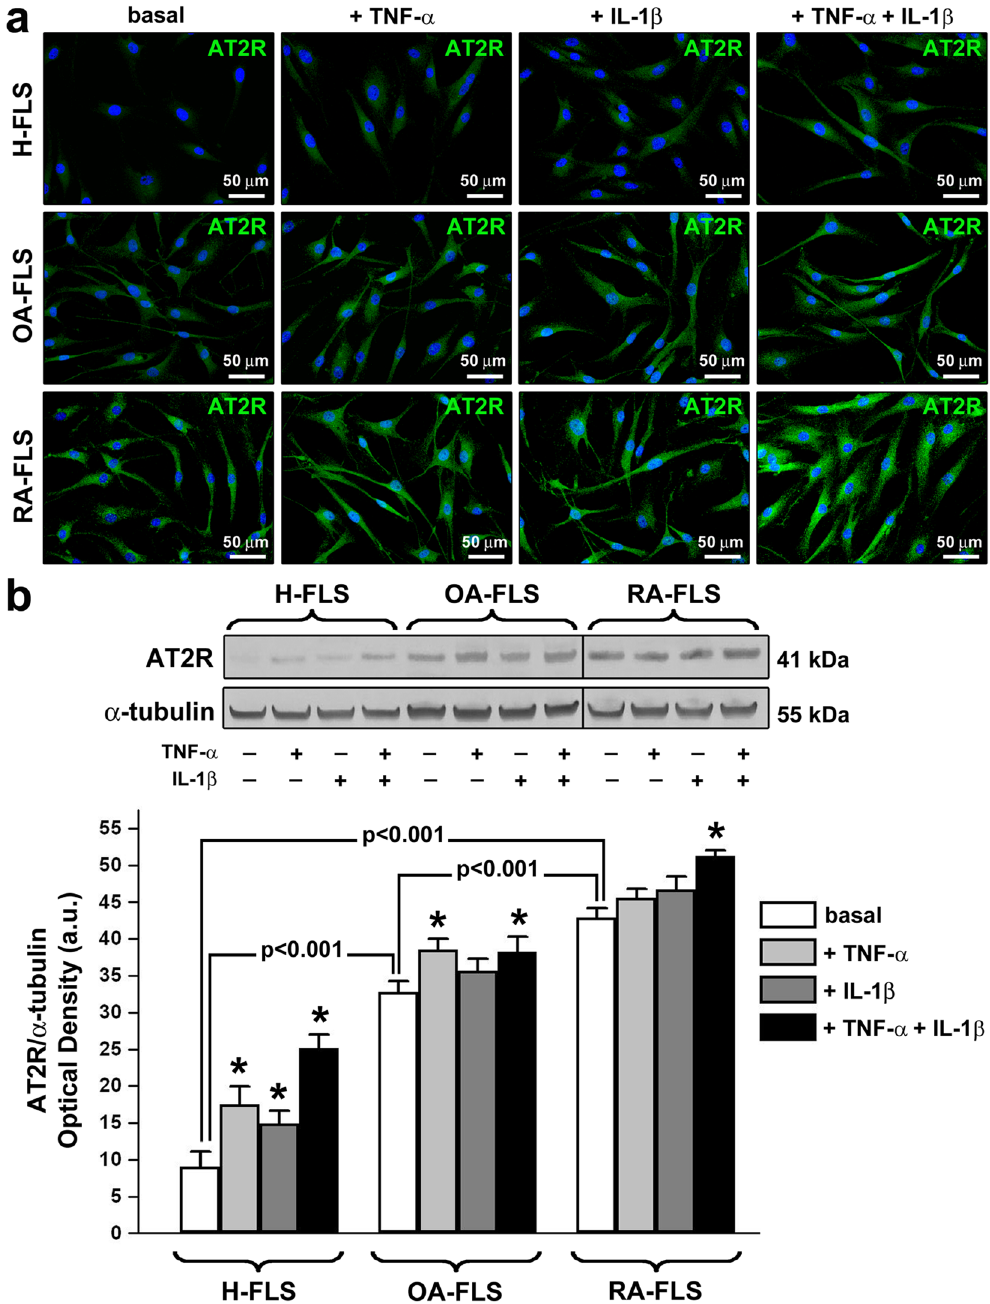
Figure 3. Expression of angiotensin II type 2 receptor (AT2R) in fibroblast-like synoviocytes (FLS) from healthy, osteoarthritis (OA) and rheumatoid arthritis (RA) synovium at baseline and after treatment with tumor necrosis factor (TNF)- α and interleukin (IL)-1 β , alone or in combination. ( a ) Representative microphotographs of FLS isolated from healthy (H-FLS), OA (OA-FLS) and RA (RA-FLS) synovium subjected to immunofluorescence staining for AT2R (green) and nuclear counterstaining with 4 ′ ,6-diamidino-2- phenylindole (DAPI; blue). Scale bars are indicated in each panel. ( b ) Western blotting of total protein extracts from H-FLS, OA-FLS and RA-FLS at basal condition and treated with TNF- α and IL-1 β , alone or in combination, assayed with anti-AT2R antibody; α -tubulin was used as a loading control. Representative cropped immunoblots are shown. All samples were run on the same gel. Non-adjacent samples were separated by a black line. Numbers on the right indicate molecular weight (kDa). A protein band with the expected molecular weight of 41 kDa was detected with the anti-AT2R antibody. The densitometric analysis of the bands normalized to α -tubulin is reported in the histograms. Data are mean ± SEM of optical density in arbitrary units (a.u.). Student’s t test was used for statistical analysis; * p < 0.05 versus the respective basal condition for each cell type. Results are representative of three independent experiments performed with each one of the six H-FLS, six OA-FLS and six RA-FLS